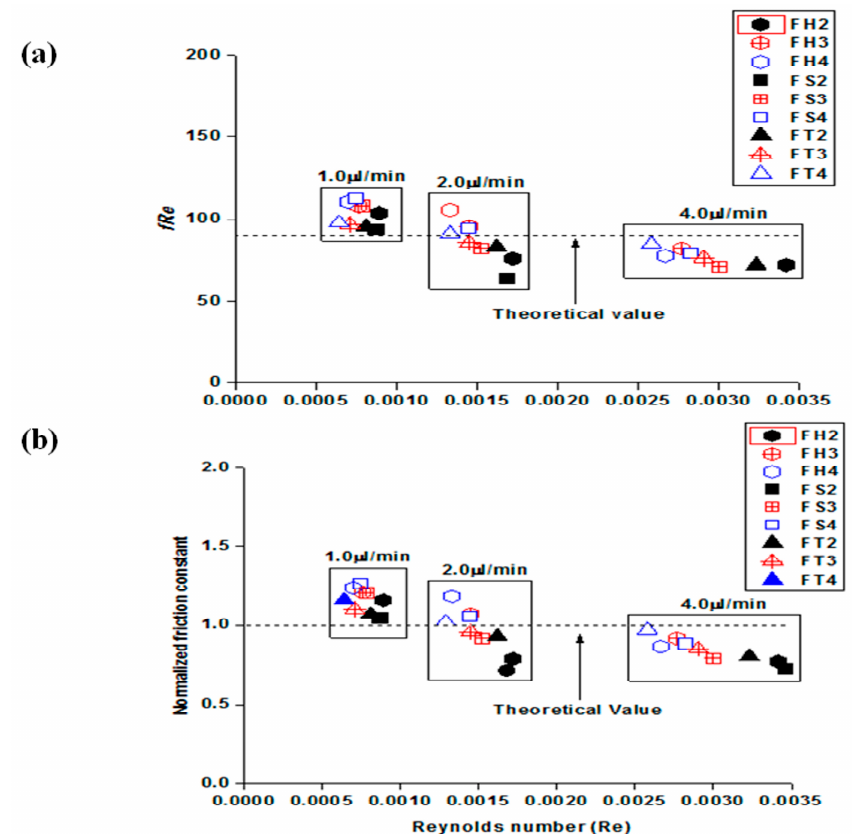
Figure 4. ( a ) Friction constants of three different shapes of obstacles at three different flow rates and ( b ) the normalized friction constants as a function of a low Reynolds number with three different shapes of obstacles. Table 4. Analysis of the fractional uncertainty in friction factor and Reynolds number. Fractional Uncertainty (%) in Reynolds Number